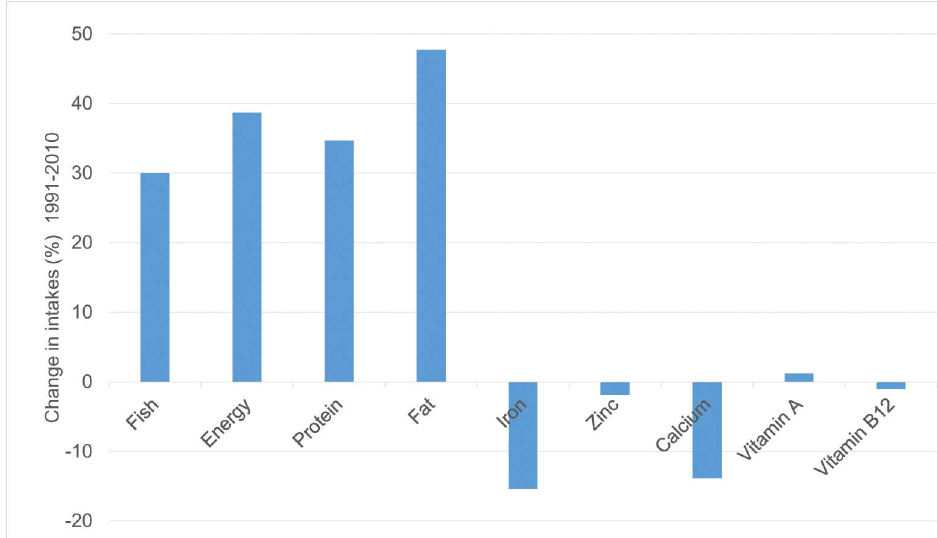
Fig 1. Change (%) in fish consumption and nutrient intakes from fish from 1991 as baseline to 2010 * . * All changesexcept for zinc, vitamin A and vitamin B12 between 1991and 2010 are statistically significant P <